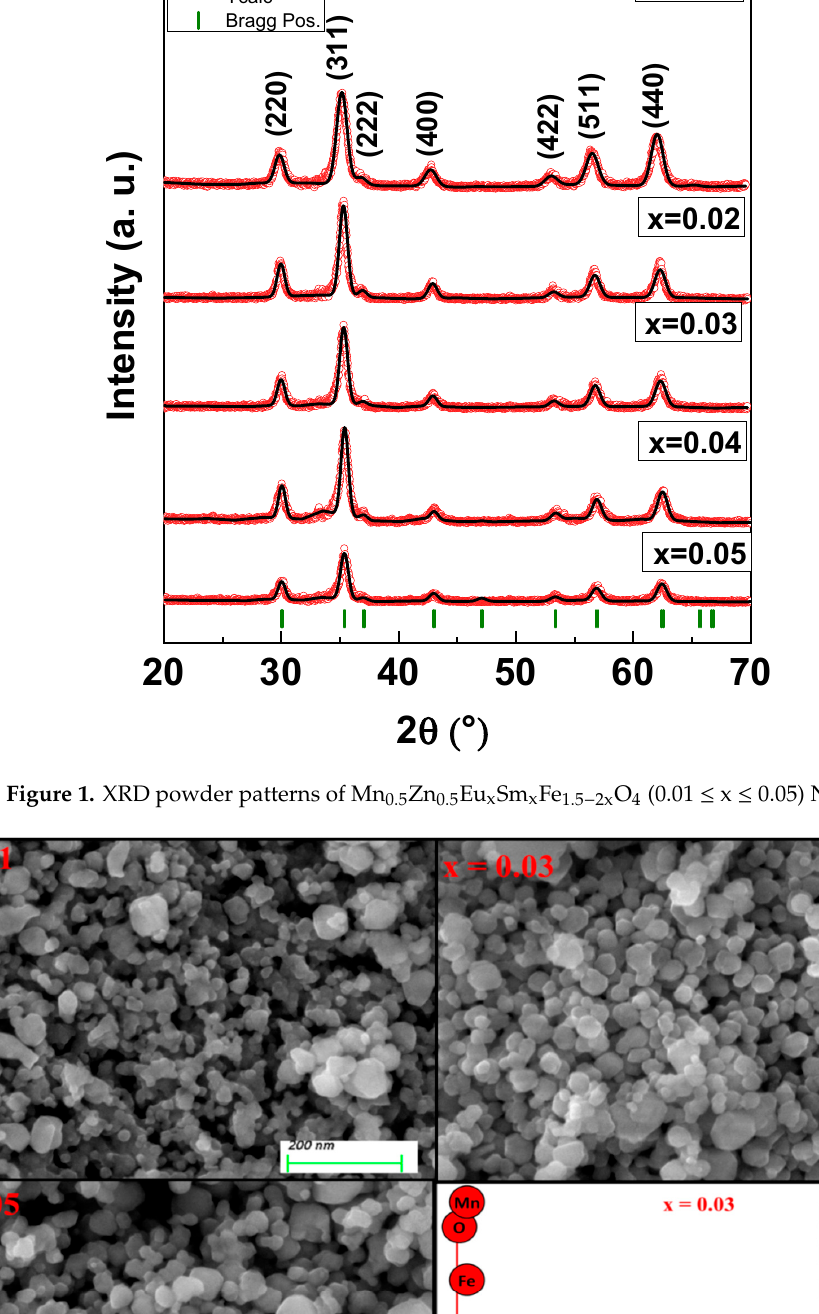
Figure 2. SEM of Mn 0.5 Zn 0.5 Eu x Sm x Fe 1.5 − 2x O 4 for x = 0.01, 0.03, and 0.05 and EDX x = 0.03 NPs.